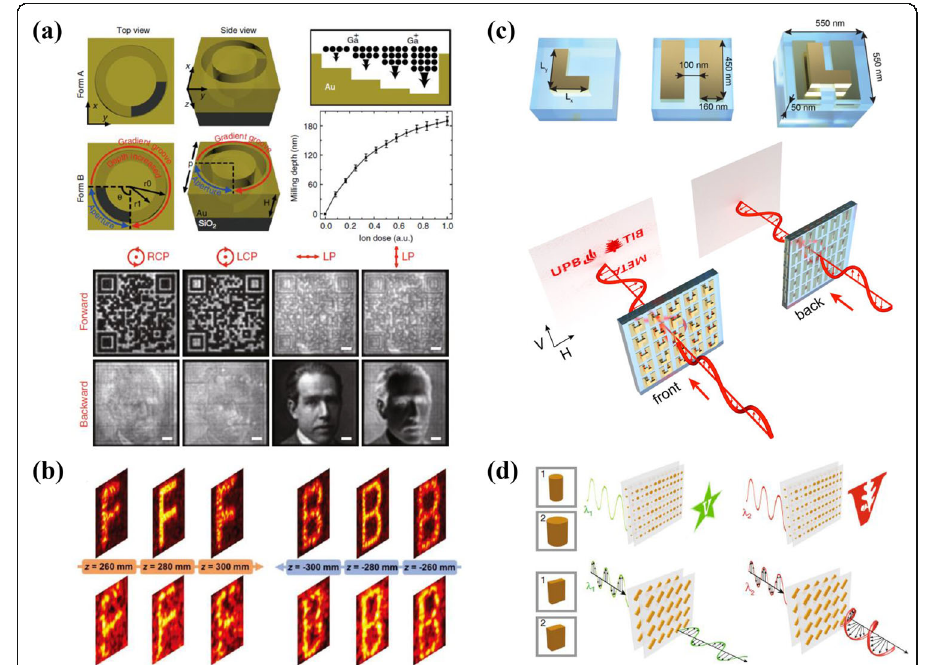
Fig. 8 Janus and bilayer metasurfaces holography. a Direction-controlled polarization-encrypted data storage based on Janus metasurface composed of two enantiomeric plasmonic helical nanoapertures. Experimental results of the Janus metasurface in both the forward and backward directions for various incident polarizations are shown on the bottom [110]. b Simulated and experimental results of proposed directional Janus metasurface observed at different observation planes at 8.6 GHz for forward and backward waves [111]. c Schematic illustration of cascaded two-layer polarization sensitive meta-hologram. The unit- cell composed of L shape antenna and dimer layer are shown on the top [112]. d Schematic of multi- wavelength holograms, multi-wavelength waveplates, and 3D holograms based on dielectric bilayer metasurfaces